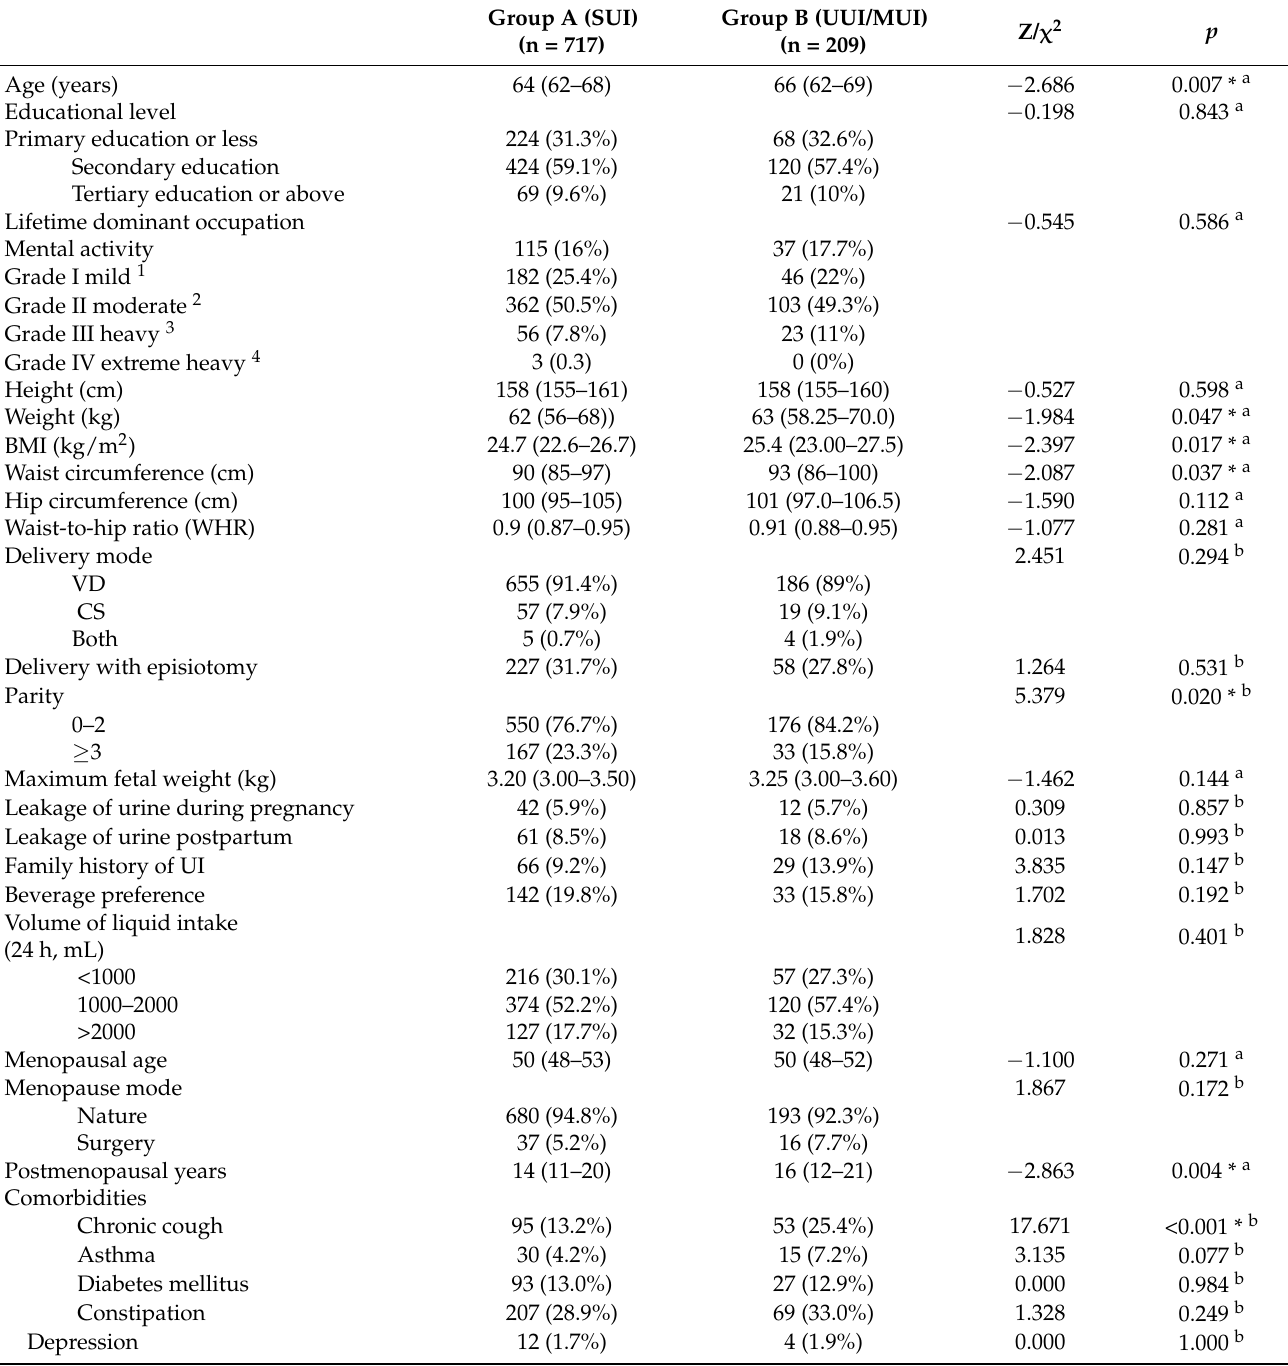
Table 2. Demographic and clinical data of the participants in the two